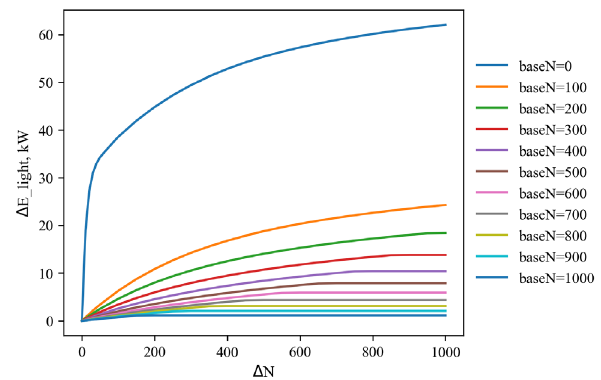
Figure 7. Influence of ∆N on ∆E light at different existing occupancy levels.